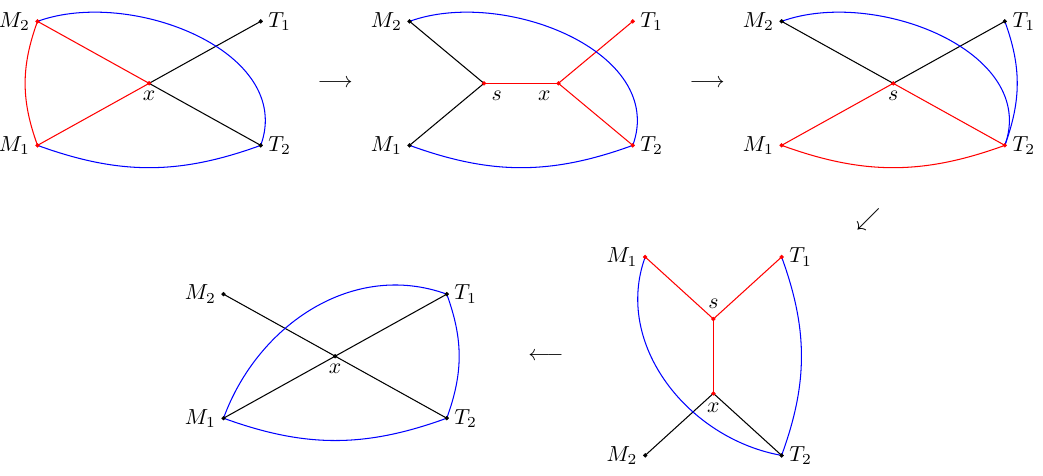
Figure 16 . Diagrammatic representations of the sequential application of the ultimate penthagon identity. We use black lines for chirals charged under the gauge symmetry, while blue lines for gauge singlets. At each step, we apply the ultimate penthagon identity on the block highlighted in